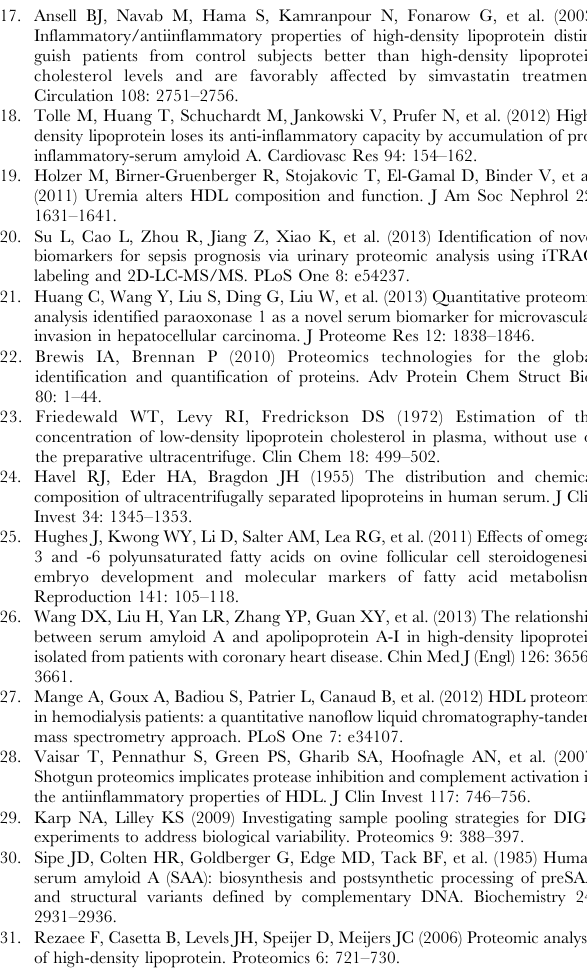
Table S1 The two density cutoff values of ultracentri- fugation technique for HDL isolation. Table S2 The purity of 20 random HDL samples. Table S3 Protein summary report identified in HDL samples by